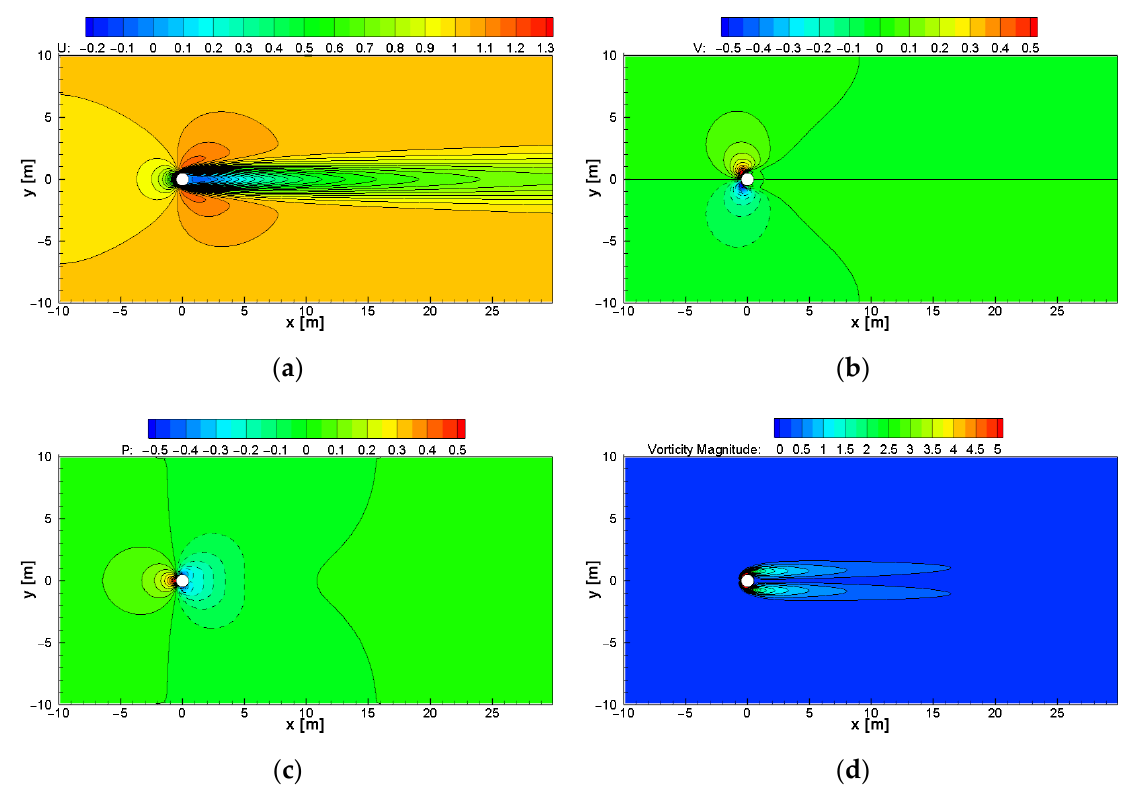
Figure 8. Contour maps of ( a ) u , ( b ) v , ( c ) p , and ( d ) vorticity magnitude around a circular cylinder ( Re = 100, t = 400 s).